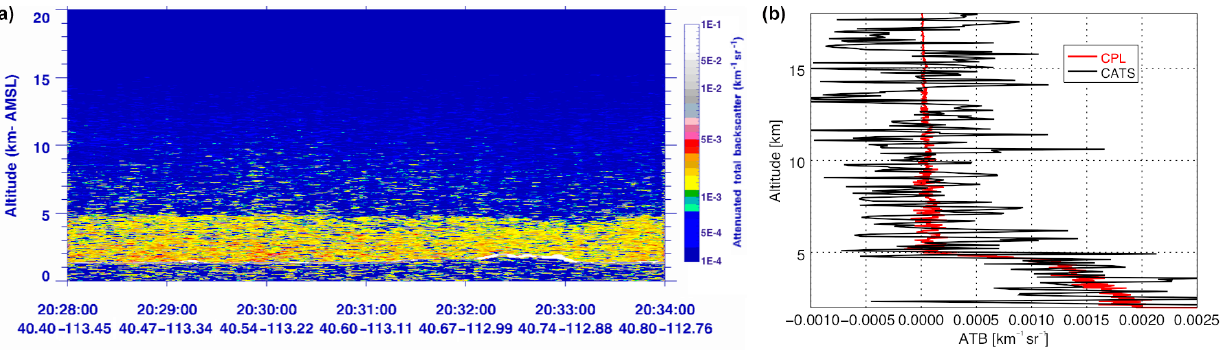
Figure 6. The 20 August 2015 CATS/CPL coincident flight. The CPL 70km coincident segment curtain plot (a) was used to compute the mean ATB profile (b) from CPL along the same path as CATS. The CATS and CPL data show good agreement despite higher noise levels in the CATS profile due to daytime retrieval